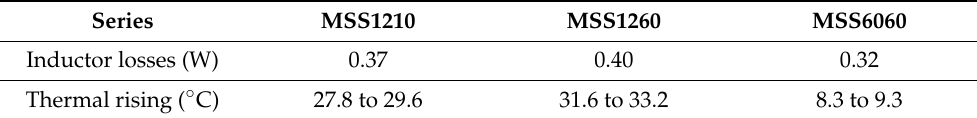
Table 6. Thermal rising of a 22 µ H selected during optimization process of the 50 W converter.